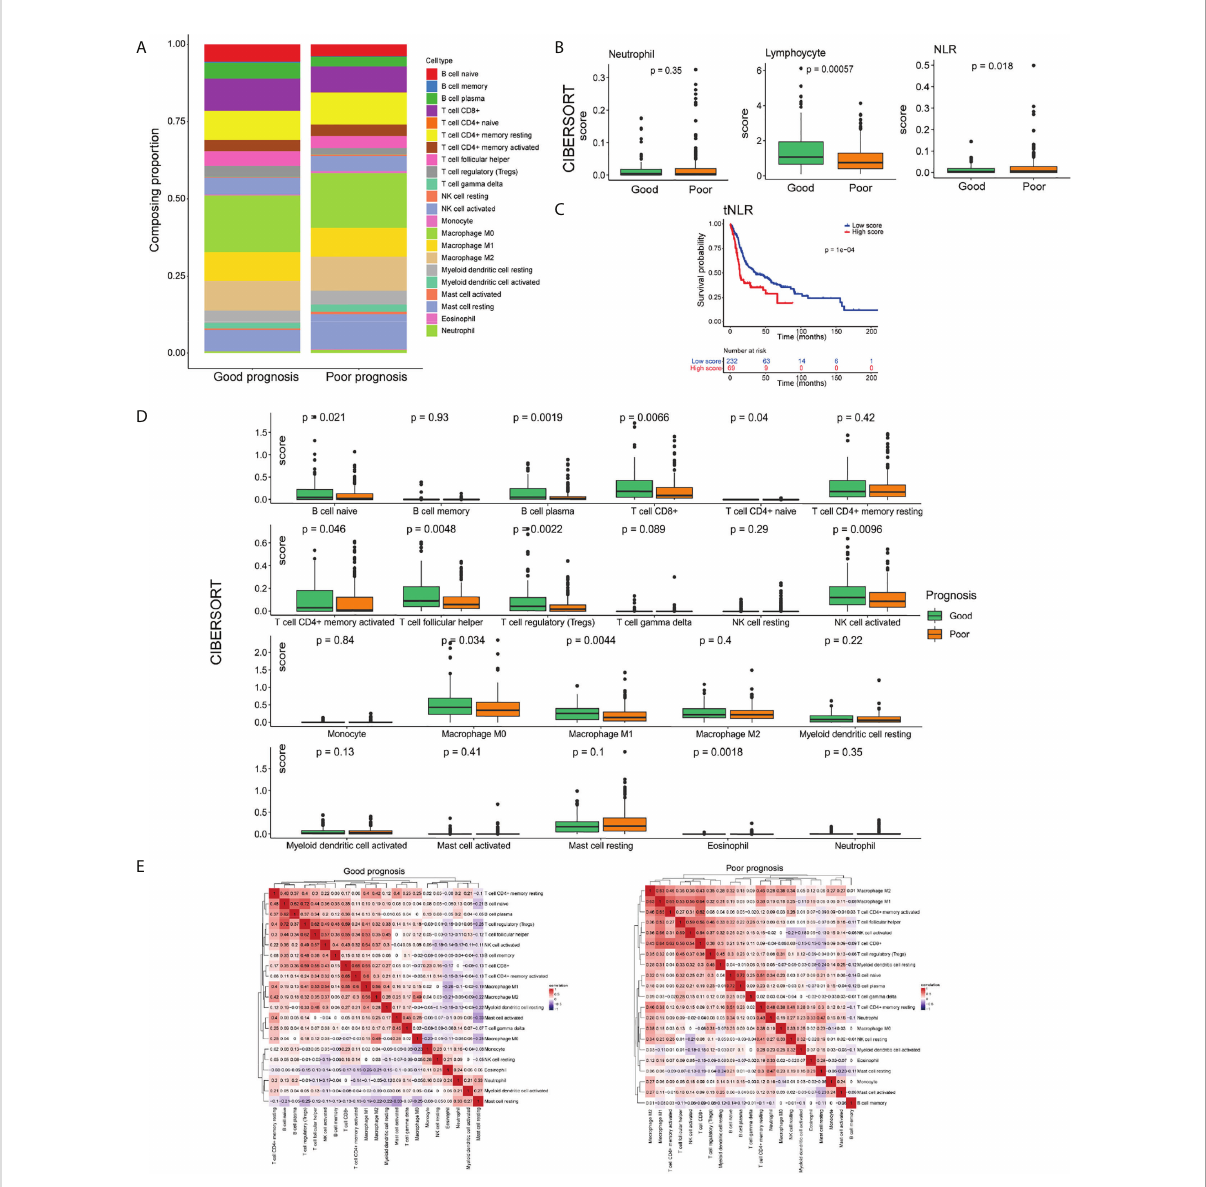
FIGURE 3 The landscape of the TIME in the HNSCC of good- and poor-prognosis groups. (A) Bar charts presenting the proportions of tumor-in fi ltrating immune cells (TIICs) in good- and poor-prognosis groups. (B) Box plots demonstrating the proportion of neutrophils, lymphocyte in fi ltration, and the tNLR in good- and poor-prognosis groups. (C) Box plots of 22 types of TIICs in good- and poor-prognosis groups. (D) Correlation heat maps demonstrating the correlation of 22 types of TIICs in good- and poor- prognosis groups. (E) Kaplan – Meier OS curves of patients with low and high